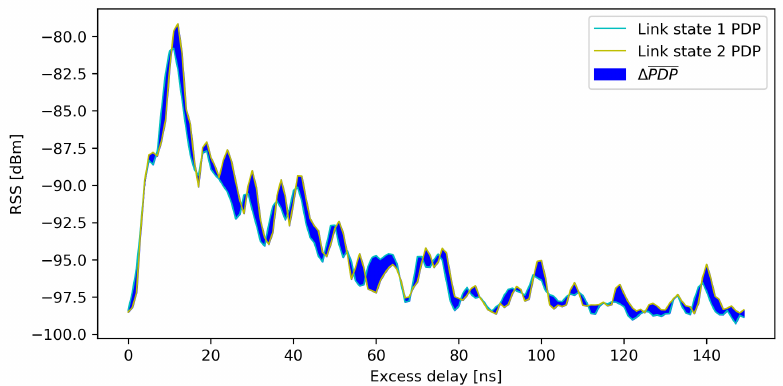
Figure 3. Two PDPs for different states of the same radio link. Link state 1 PDP presents the average PDP for one radio environment state. Link state 2 PDP presents the average PDP for another state of radio environment, where a person changed the location within the same environment. The difference between two states is presented with absolute PDP difference marked in